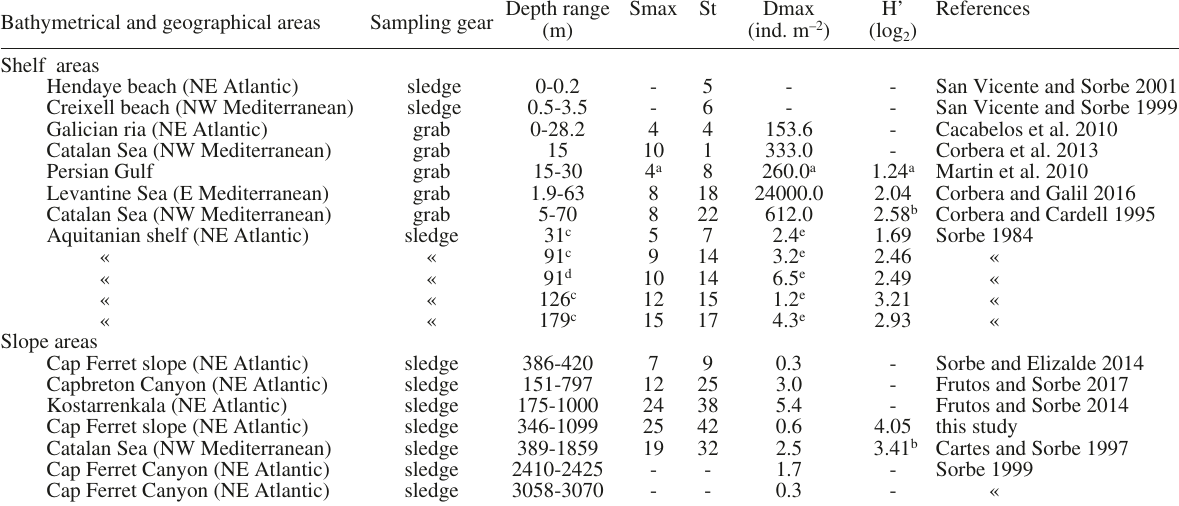
Table 7. – Comparison of structural data reported for shelf and slope cumacean assemblages from various geographical areas. Smax/Dmax, maximum value of species richness/abundance recorded at a sampling station in the study area. St, total species richness recorded in the whole study area. H’, maximum value of the Shannon-Wiener diversity index recorded at a sampling station of the study area. –, no data. a unpublished data; b calculated from rough data mentioned in reference; c, d daytime, night-time samplings; e recalculted from original data in ind./100 m 3 (conversion factor: 0.515 10 –2